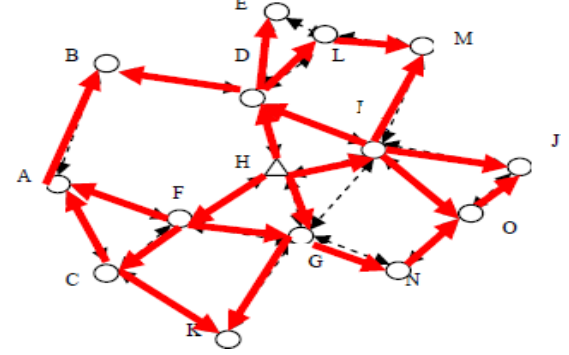
Figure 4: Representation of the Flooding